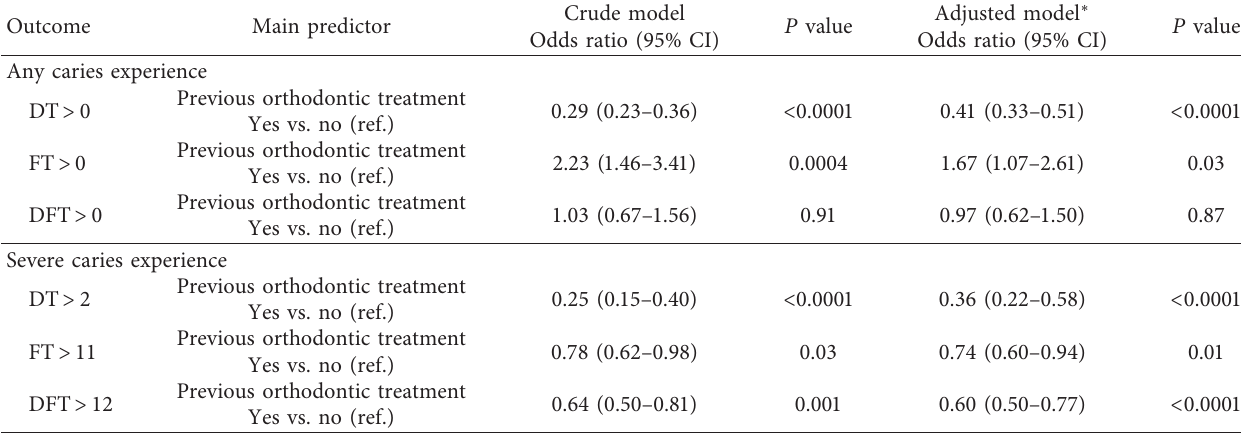
Table 4: Crude and adjusted logistic regression models of the association between previous orthodontic treatment and caries experience ( n �